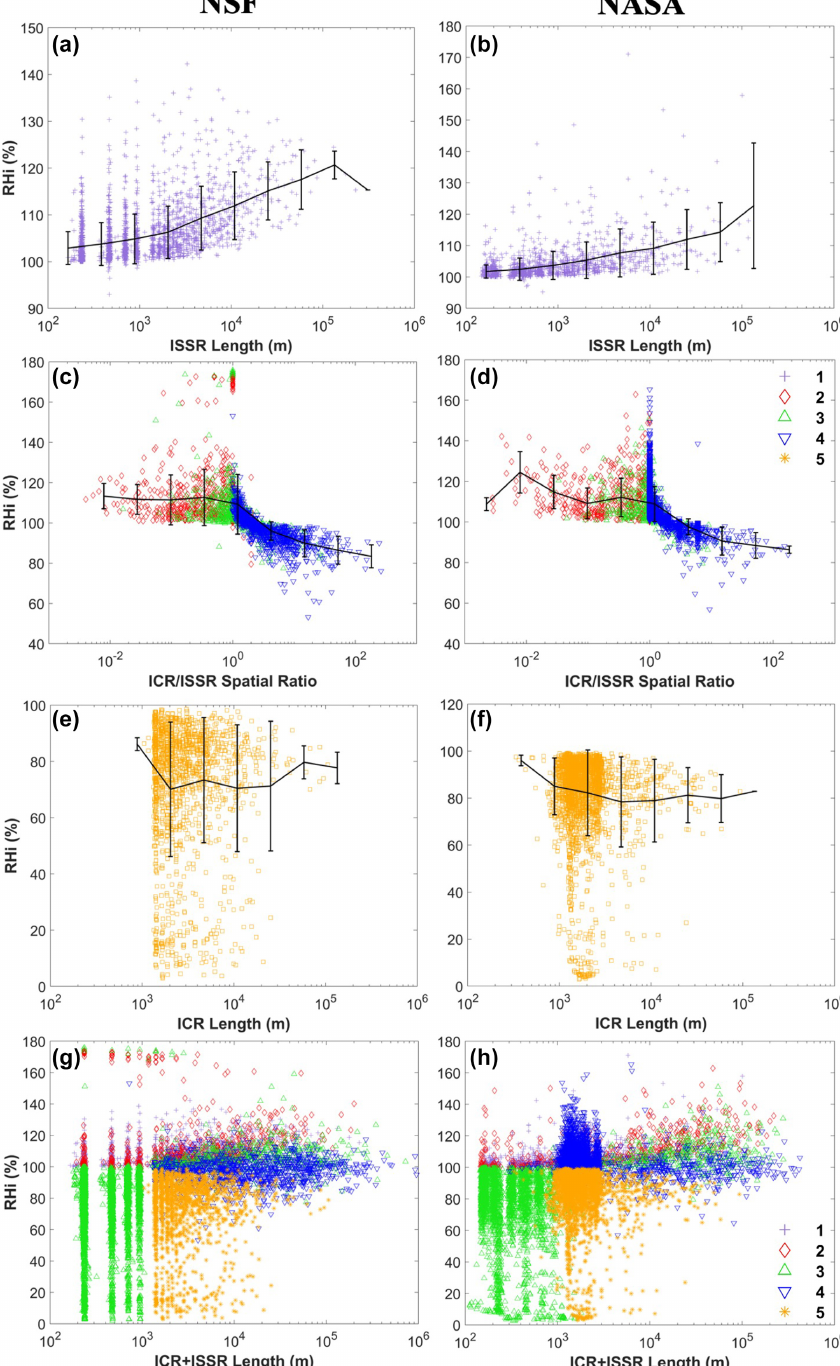
Figure 4. RHi distributions for (a, b) phase 1, (c, d) phases 2 to 4, (e, f) phase 5 and (g, h) all five evolution phases. Observations from NSF and NASA campaigns are shown in column 1 and 2, respectively. All error bars in this figure and the following figures represent ± 1 standard